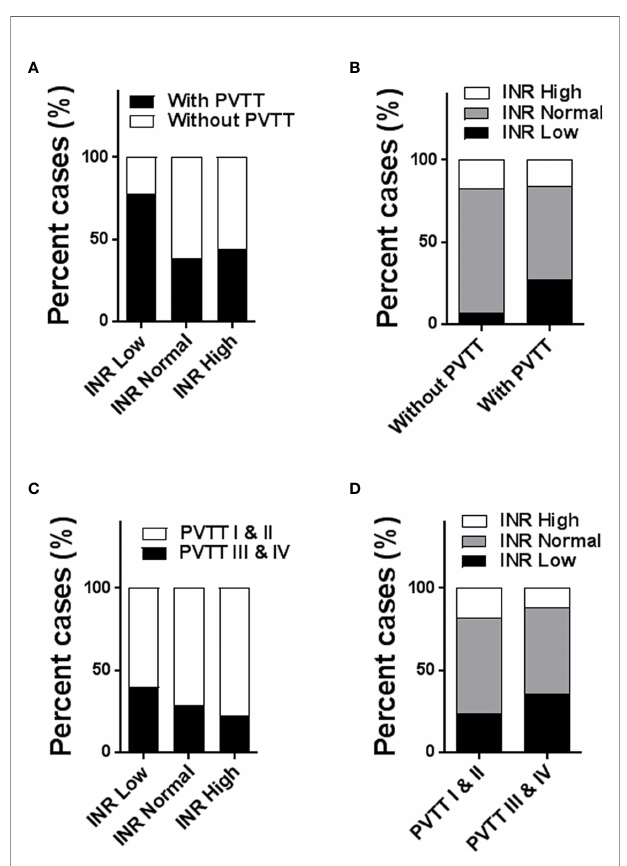
FIGURE 2 | Histogram to show the association of preoperative INR level with incidence and extent of PVTT (1005 patients with PVTT vs 1202 patients without PVTT; 698 patients with types I/II PVTT vs 307 patients with types III/ IV PVTT). The incidence rates of PVTT among the Low, Normal, and High INR groups (A) ; the distributions of INR level between patients with and without PVTT (B) ; the incidence rates of types I/II and types III/IV PVTT among the Low, Normal, and High INR groups (C) ; the distributions of INR level between patients with types I/II PVTT and types III/IV PVTT (D) . PVTT, portal vein tumor thrombus; INR, international normalized